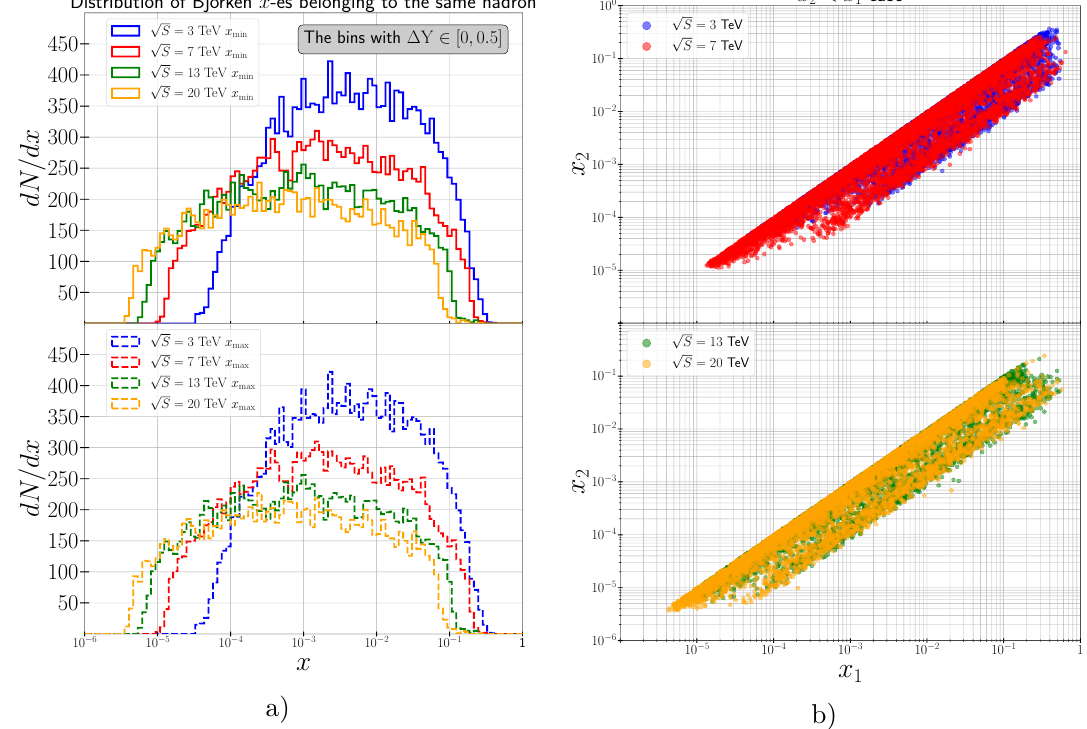
Figure 11 . Distribution of Bjorken- x ’es belonging to the proton with the D j for the bin with ∆Y ∈ [0 , 0 . 5] . Left plot: distribution of the minimal and maximal Bjorken- x ’es for 3, 7, 13 and 20 TeV collision energies. Right plot: distribution of the DPS events contributing to the ∆Y ∈ [0 , 0 . 5] bin in the x 1 - x 2 plane for the x 2 < x 1